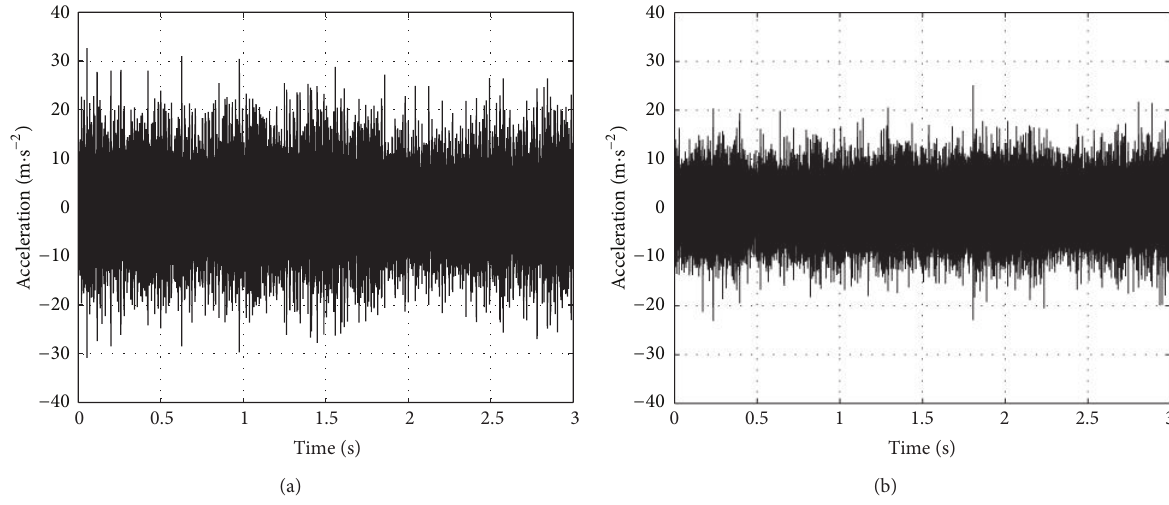
Figure 4: Vibroacoustic signals for two welding conditions. (a) Condition 1; (b) condition 2.